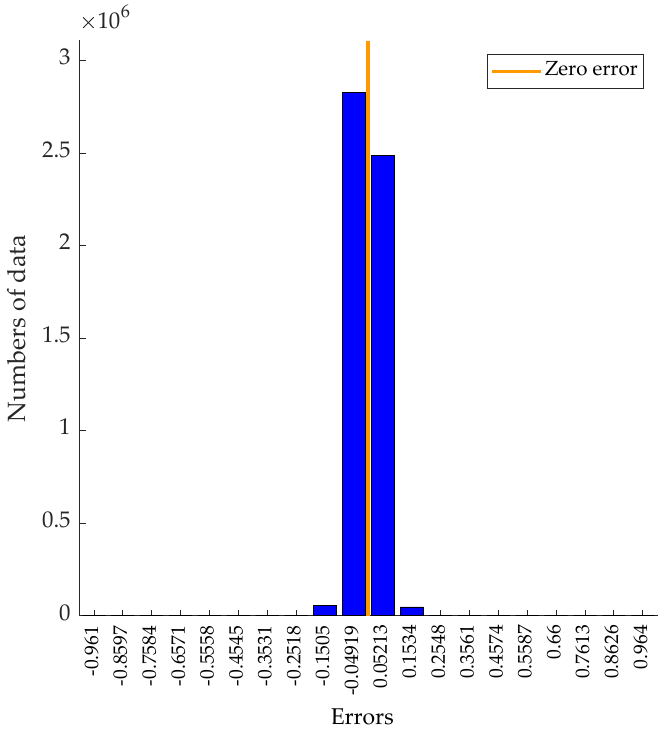
Figure 9. Error histogram of the training process.